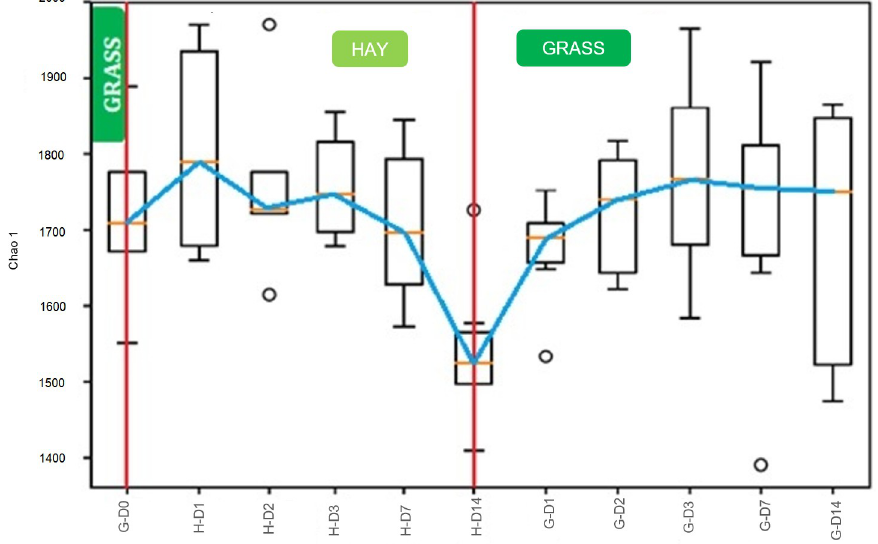
Fig 2. Chao1 for bacterial communities in the faeces of the ponies for different days of experiment. Boxplot comparing estimated richness (n = 6). Red bars show abrupt changes: 1 st from grass (G) to hay (H), 2 nd from hay to grass. Blue line connects the means (orange lines). Circles represent outliers. D: